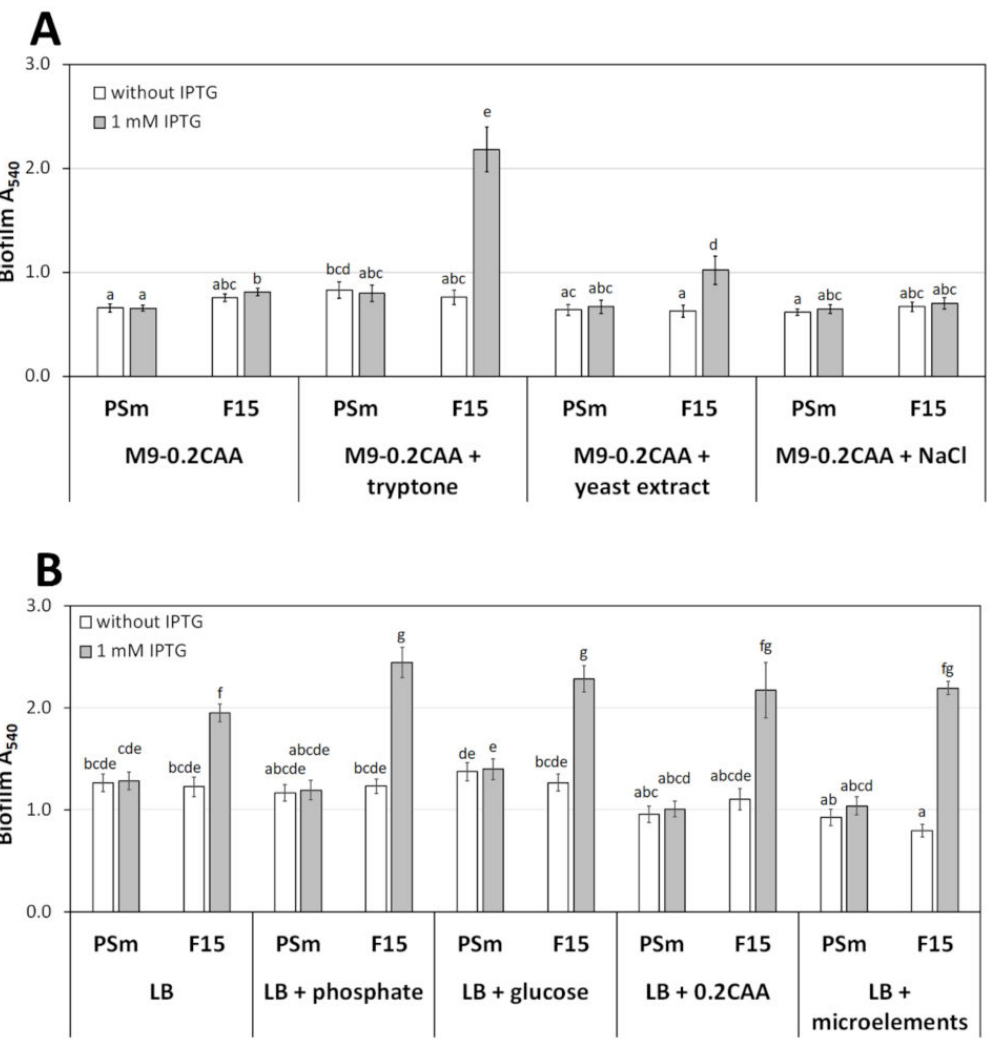
Figure 2. The biofilm of P. putida strains PSm and F15 in media supplemented with individual components. ( A ) Biofilm formation in M9-0.2CAA supplemented with single components of LB, and ( B ) biofilm formation in LB medium supplemented with single components of M9-0.2CAA. The arithmetical averages of at least four independent measurement sets are shown. Brackets show the 95% confidence intervals, and the homogenous groups are shown above columns by the lower-case letters. Identical letters denote non-significant differences ( p ≥ 0.05) between averages of